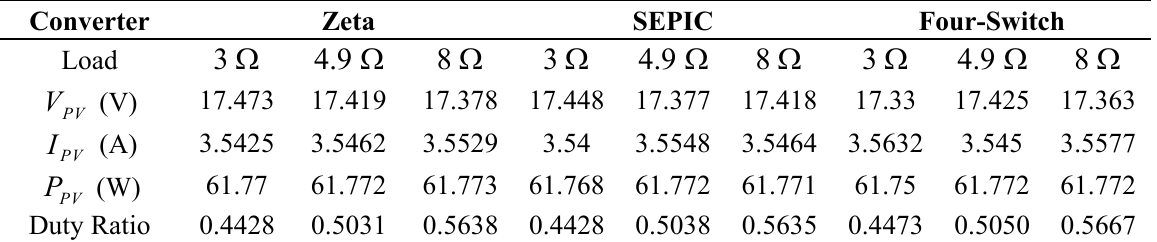
Table 3. Summaries of the MPPT circuit simulations